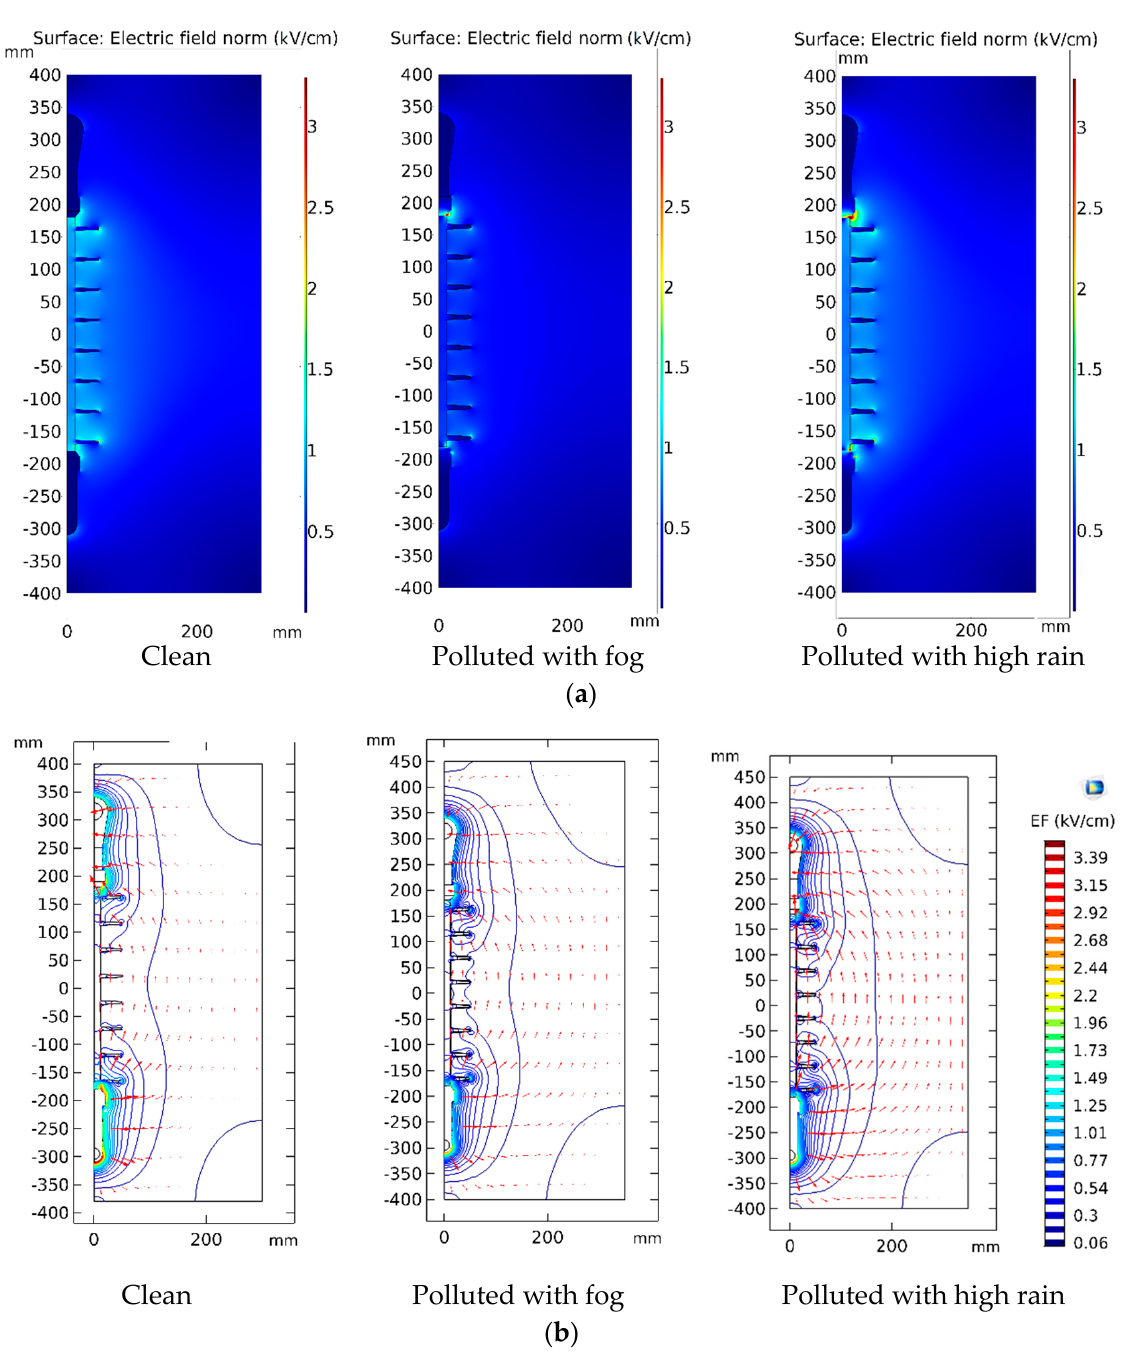
Figure 14. Electric field distribution of insulator type I: ( a ) Surface plot; ( b ) Contour plot.